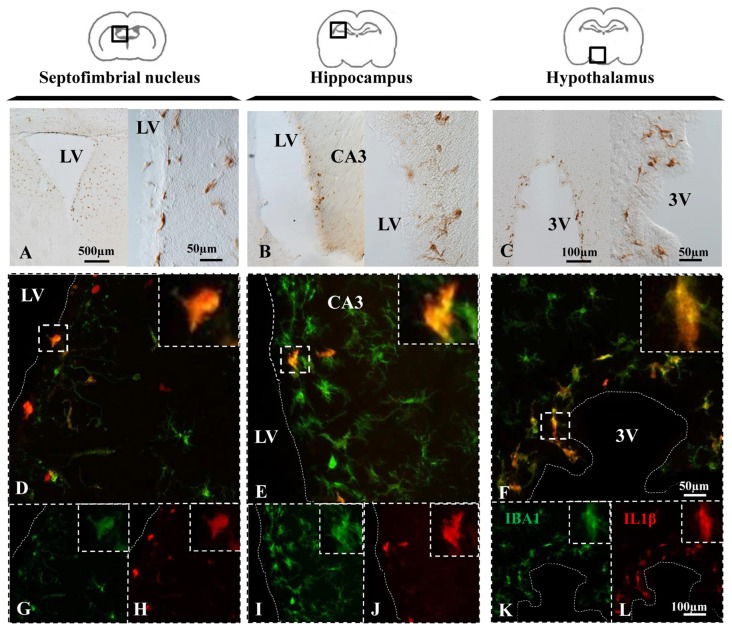
NA induces IL-1β expression in microglial cells. (A–C) Brain sections of rats sacrificed 12 h after NA injection were immunostained for IL-1β. Positive cells appeared near the ventricle in all the areas studied, indicating an inflammatory reaction. (D–L) Parallel sections from the septofimbrial nucleus (D,G,H), hippocampus (E,I,J) and hypothalamus (F,K,L) were double-labeled by immunofluorescence with IBA1 (green) and IL-1β (red) antibodies. Some cells show label with both makers, while many others do not express IL-1β. Samples from saline injected animals did not display IL-1β staining (data not shown). Dashed lines indicate the ventricular surface. LV, lateral ventricle; CA3, field CA3 of the hippocampus; 3V, third ventricle.